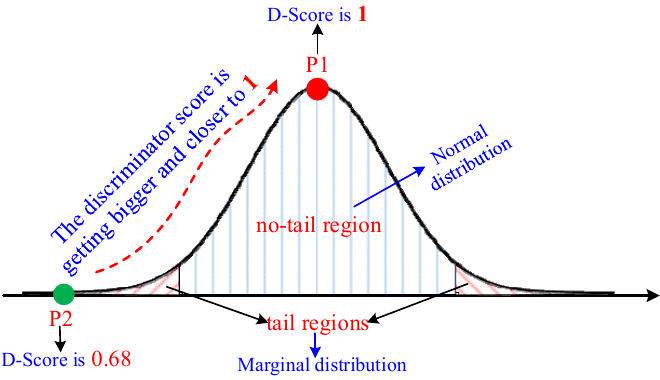
Figure 3. Correlation of discriminator score with marginal distribution.